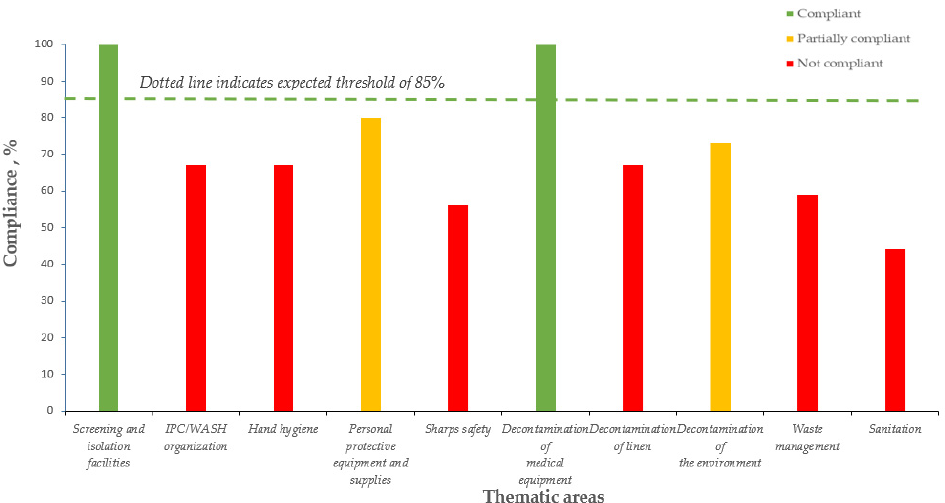
1 Infection Prevention and Control/Water Sanitation and Hygiene. 2 Average of quarterly scores for